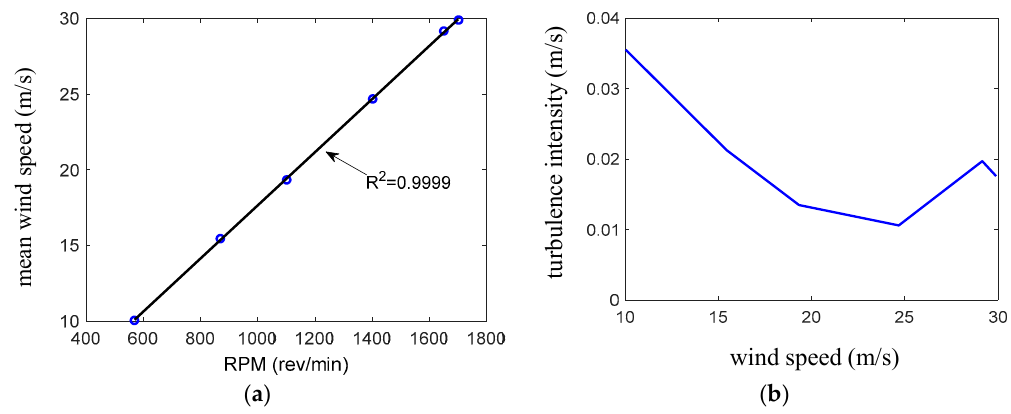
Figure 11. ( a ) RPM versus wind speed; ( b ) Turbulence intensity versus wind speed.